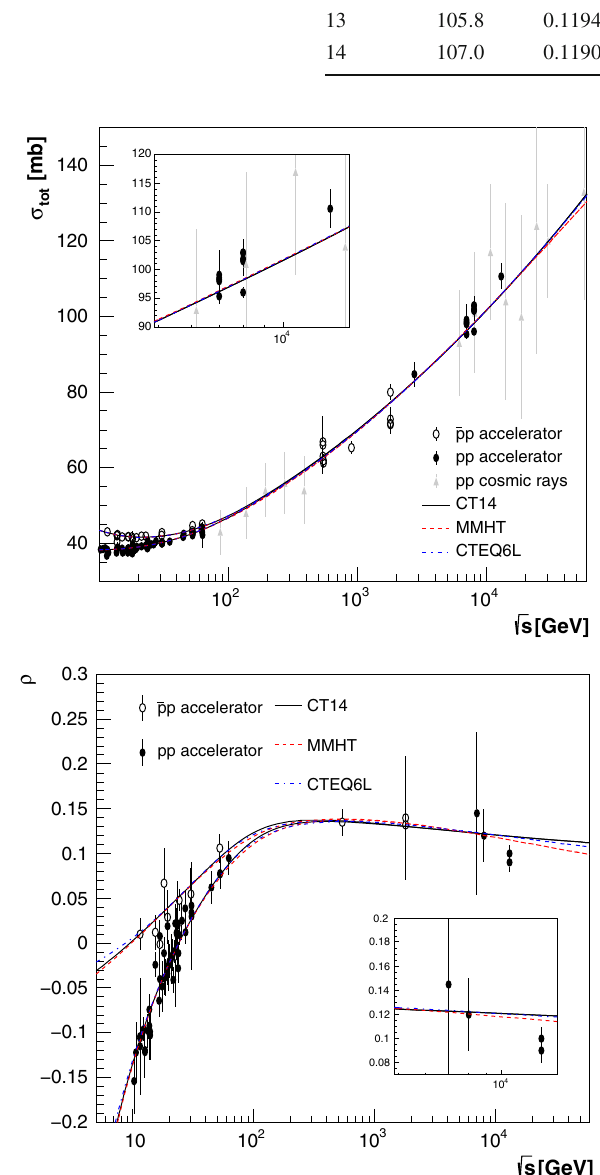
/ ¯ pp ρ pp / ¯ pp param- tot and